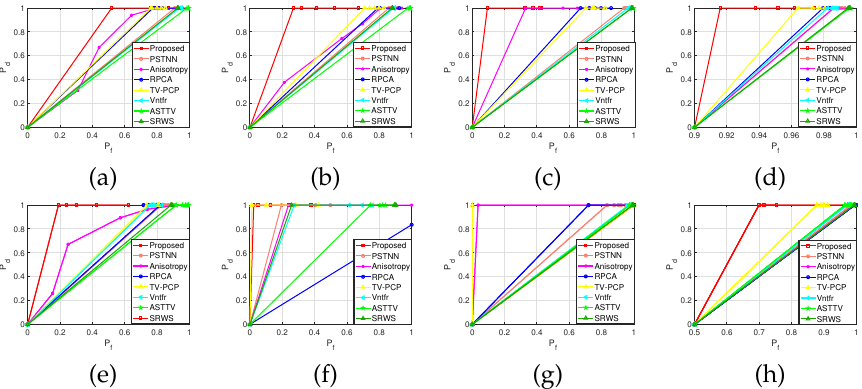
Figure 7. ( a – h ) show the ROC curves of eight sequences,